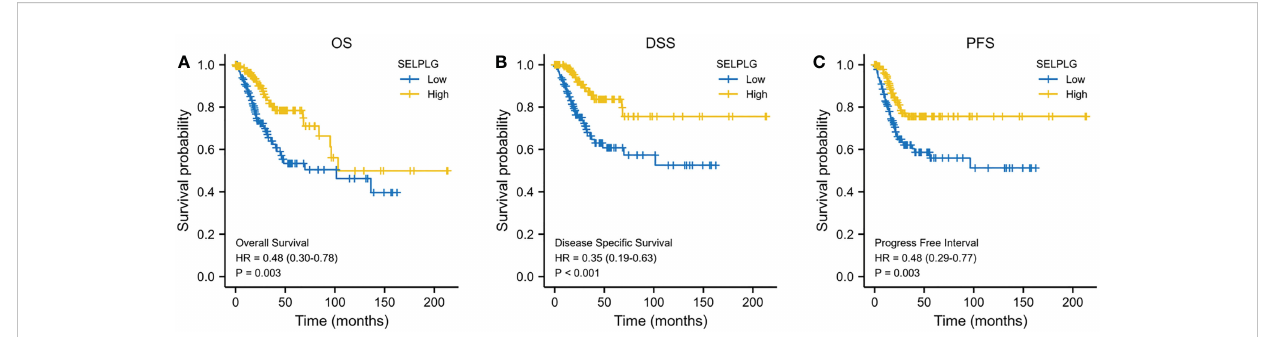
FIGURE 3 Decreased PSGL-1 mRNA levels predict a poor prognosis in cervical cancer: (A – C) Survival curves showed OS, DSS, and PFI rates of CESC patients with high PSGL-1